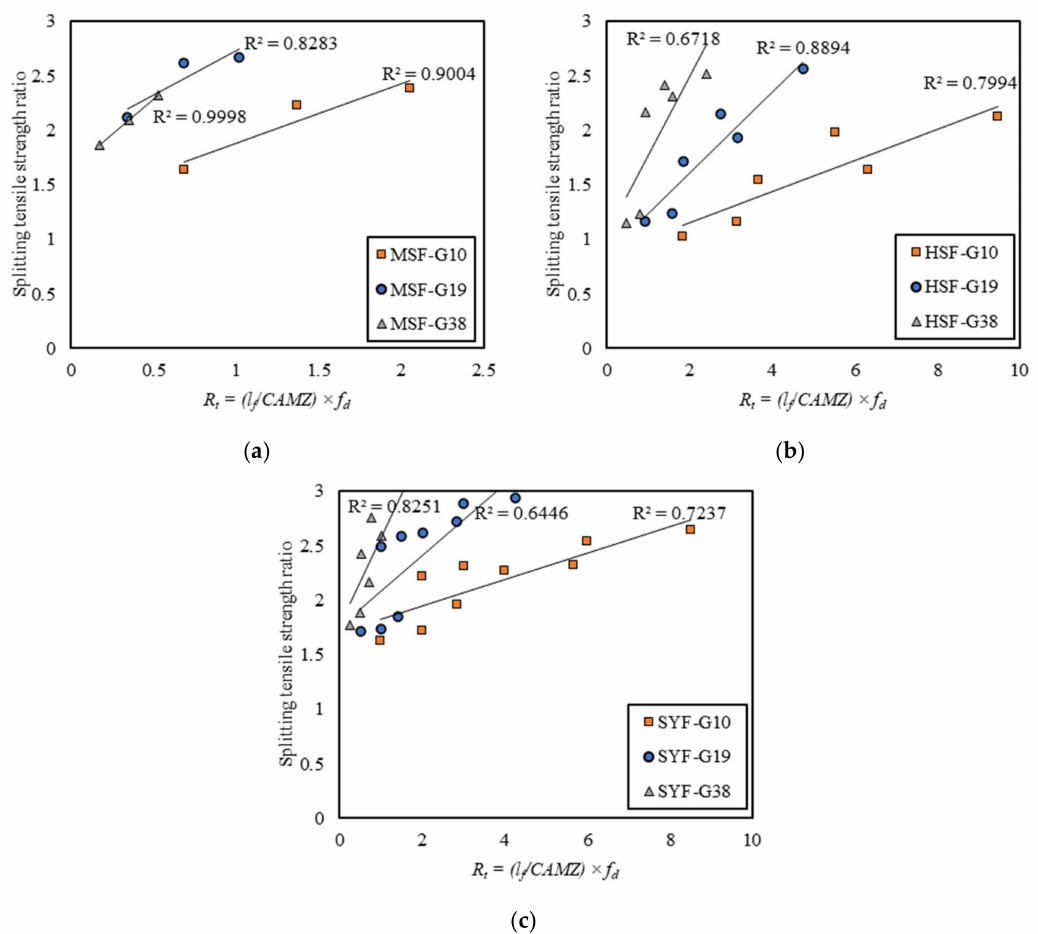
Figure 6. Effect of R t = ( l f / CAMZ ) × f d on the tensile strength ratio of ( a ) micro steel fiber (MSF), ( b ) hooked end steel fiber (HSF), and ( c ) SYF